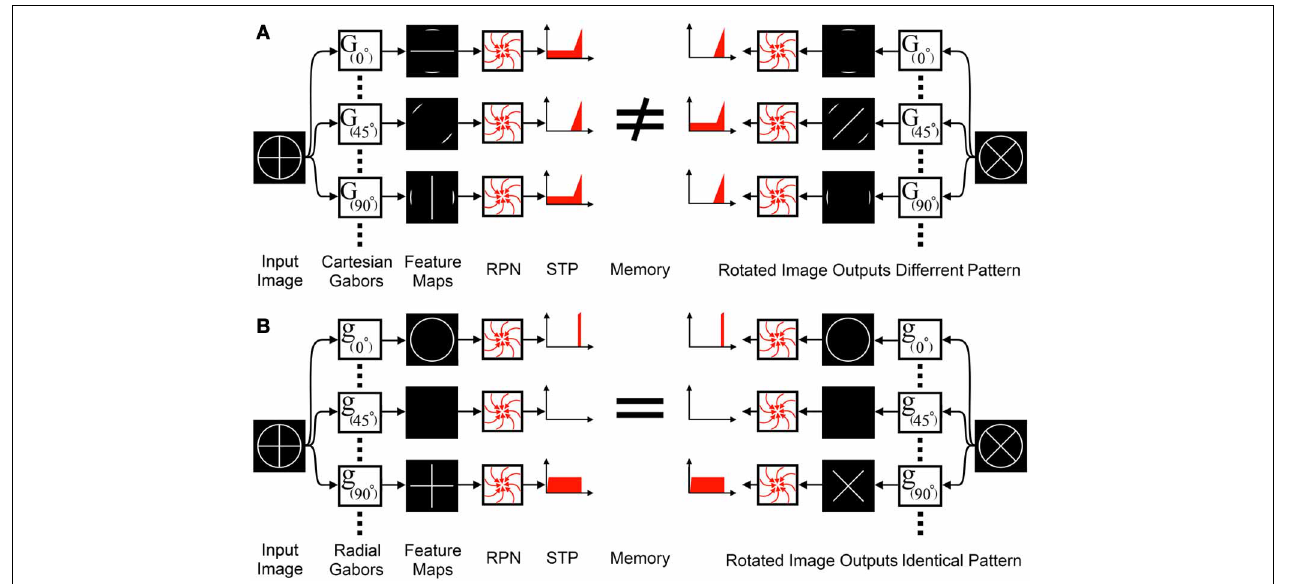
FIGURE 7 | Standard orientation sensitive feature extractors cannot precede the RPN: (A) Feature extraction via Cartesian Gabor filters, G( α ), group features into feature maps based on their orientation relative to the Cartesian coordinate system. The feature maps are input to the RPN, however, the rotational